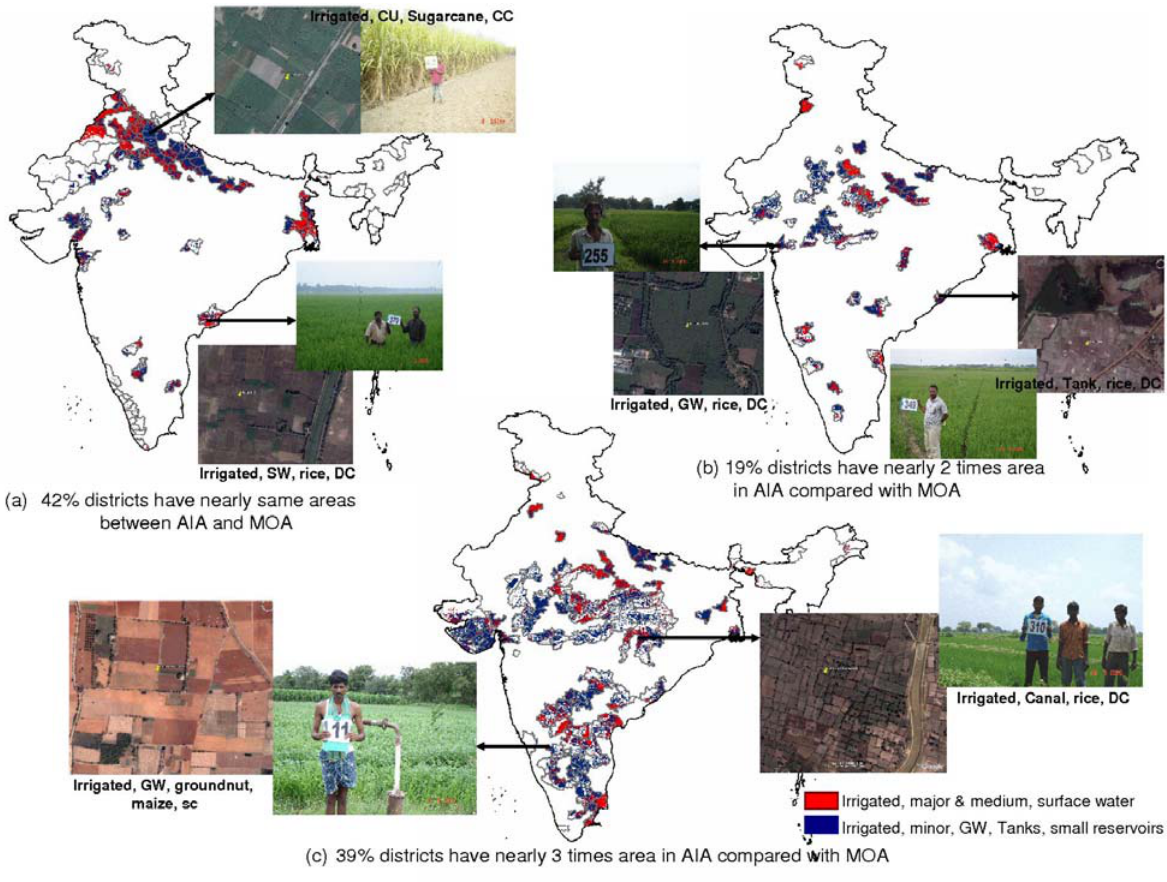
Figure 7. Uncertainties in irrigated areas illustrated with an example of India (Dheeravath, 2009). A district-wise s patial comparison between the remotely sensed irrigated areas derived using MODIS 500m data [69] and national statistics provided by Ministry of Agriculture [68] in India. The 42% of the districts where there was near 1:1 match in areas were mainly irrigated from large reservoirs. In the areas where minor irrigation (groundwater, small reservoirs, and tanks) dominated, remote sensing based estimates [69] were either twice or thrice than those reported by MOA. This was mainly because minor irrigation is inadequately reported in MOA census